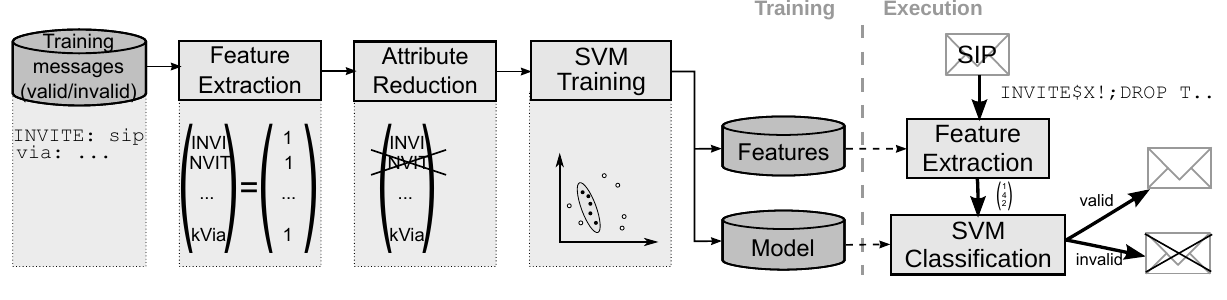
Figure 1. Classifier-based anomaly detection system with training and execution